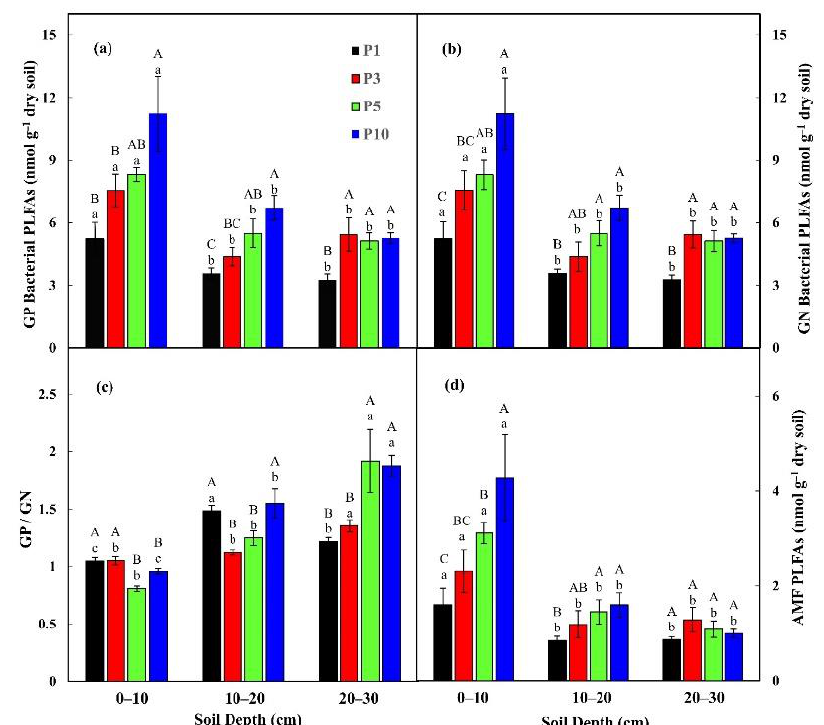
Figure 3. GP bacterial PLFAs ( a ), GN bacterial PLFAs ( b ), GP/GN: the ratio of GP bacterial PLFAs to GN bacterial PLFAs ( c ), AMF PLFAs: arbuscular mycorrhizal fungal PLFAs ( d ) in pomegranate plantation of different years at different soil depths (0–10, 10–20, and 20–30 cm). (Values followed by a different uppercase letter are significant difference ( p < 0.05) of different years in same soil depth; values followed by a different lowercase letter are significant difference of three soil depths in same year. P1, pomegranate plantation for 1 year; other names (P3; P5; P10) are in the same manner; error values are mean ± standard error; n =